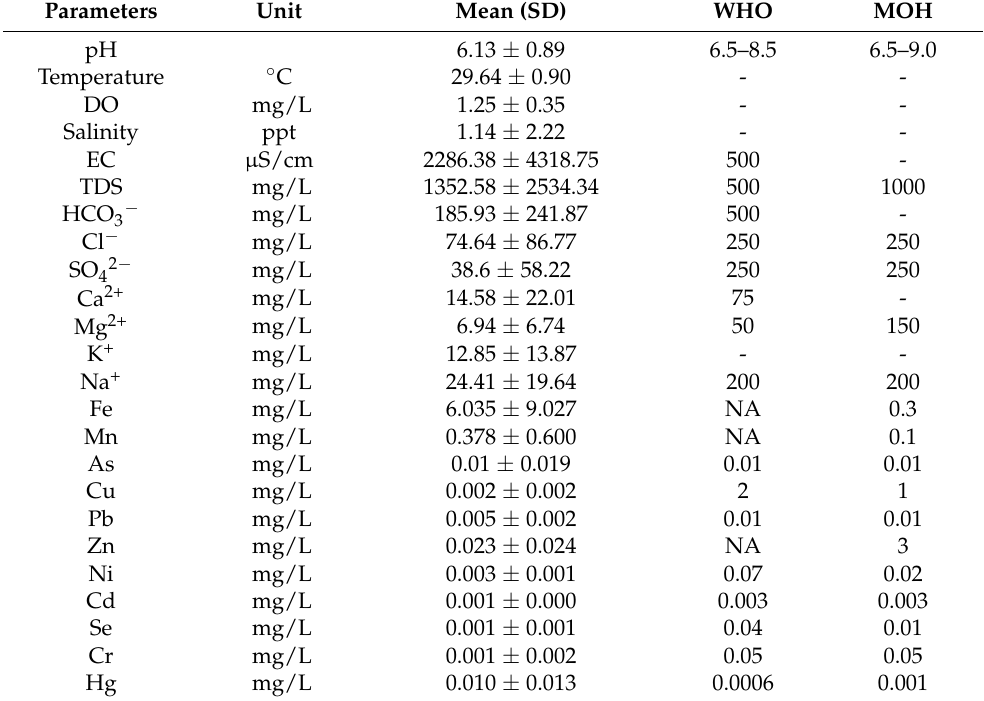
Table 5. Statistical summary of the physiochemical and heavy metal parameters in the groundwater of the Langat